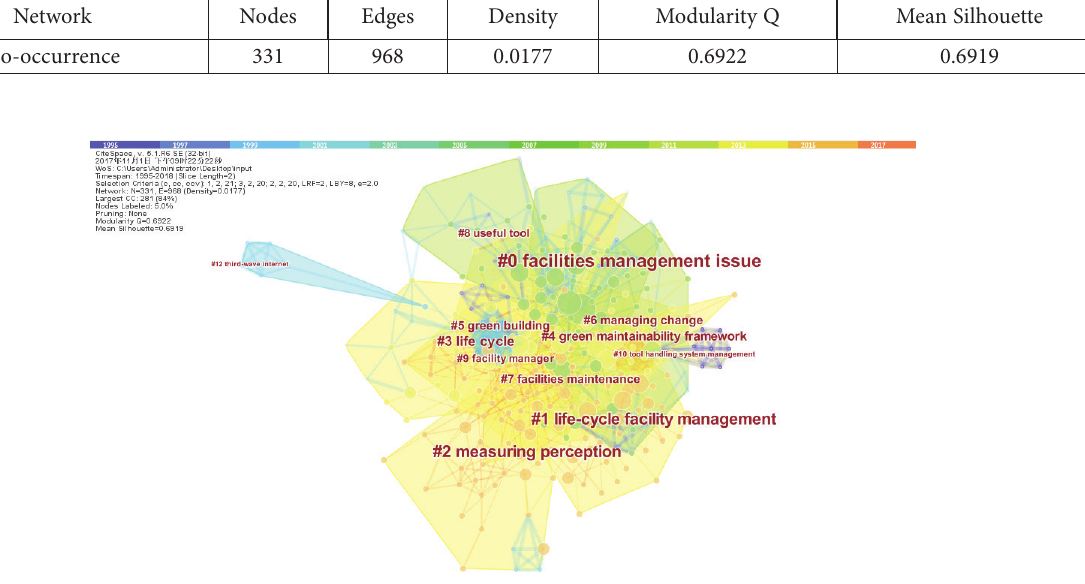
Figure 4. Cluster analysis in the FM fi